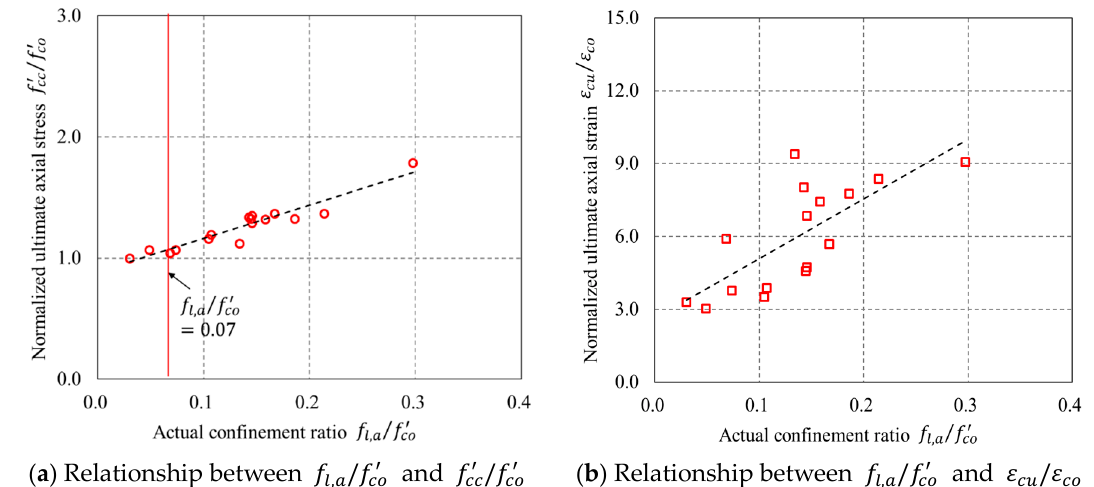
Figure 15. Relationship between actual confinement ratio ( f l , a / f (cid:48) co ) and normalized ultimate axial stress ( f (cid:48) cc / f (cid:48) co )/normalized ultimate axial strain ( ε cu / ε co ).